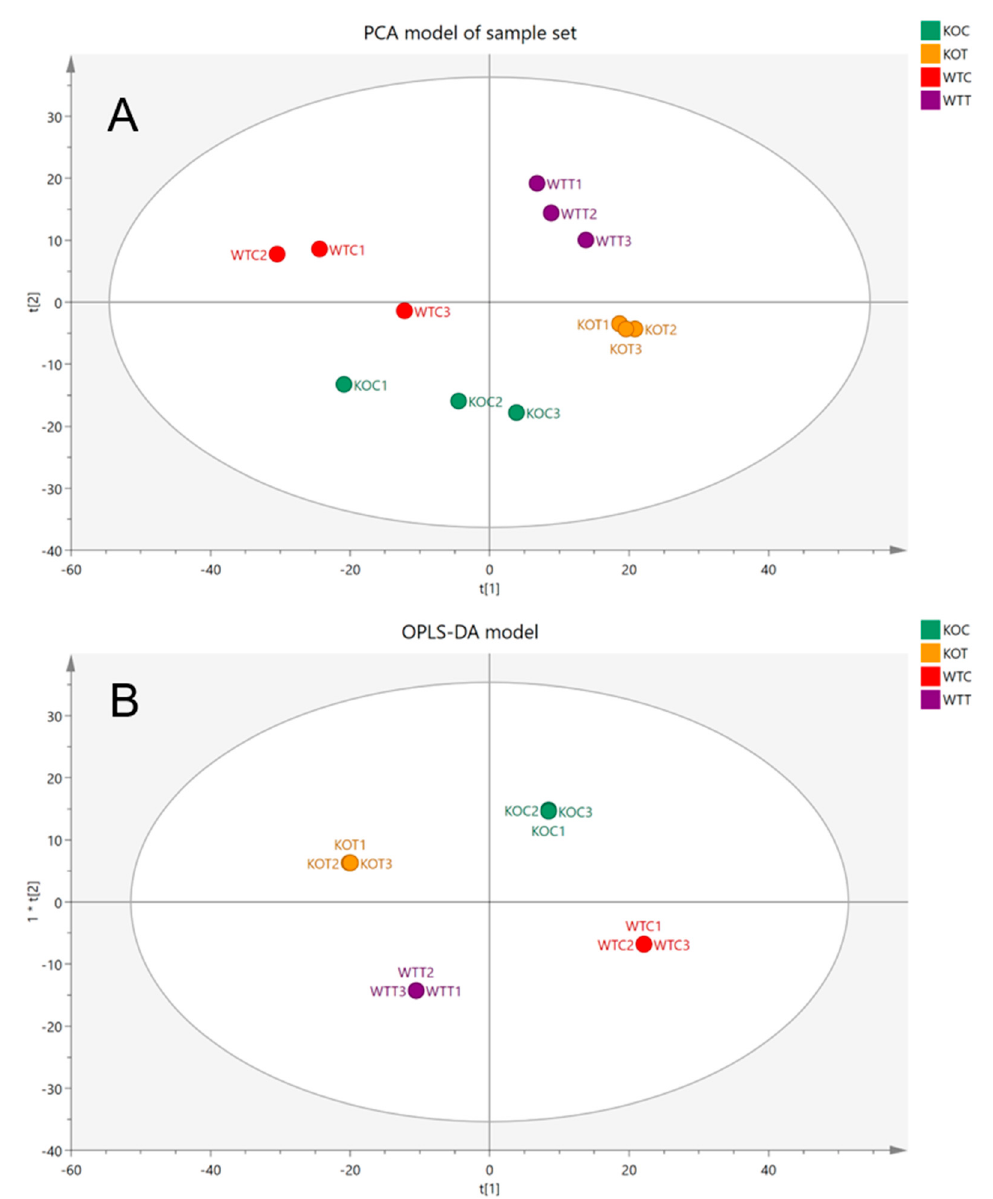
Figure 1. ( A ) Principal components analysis (PCA) plots of four different groups: WTC, wildtype control cells without treatment of oxLDL; WTT, wildtype cells treated with oxLDL; KOC, TSPO knockout control cells without treatment of oxLDL; KOT, TSPO knockout cells treated with oxLDL. ( B ) OPLS-DA score plots the samples according to their classification colored based on their group and the reading of 1106 putative metabolites.